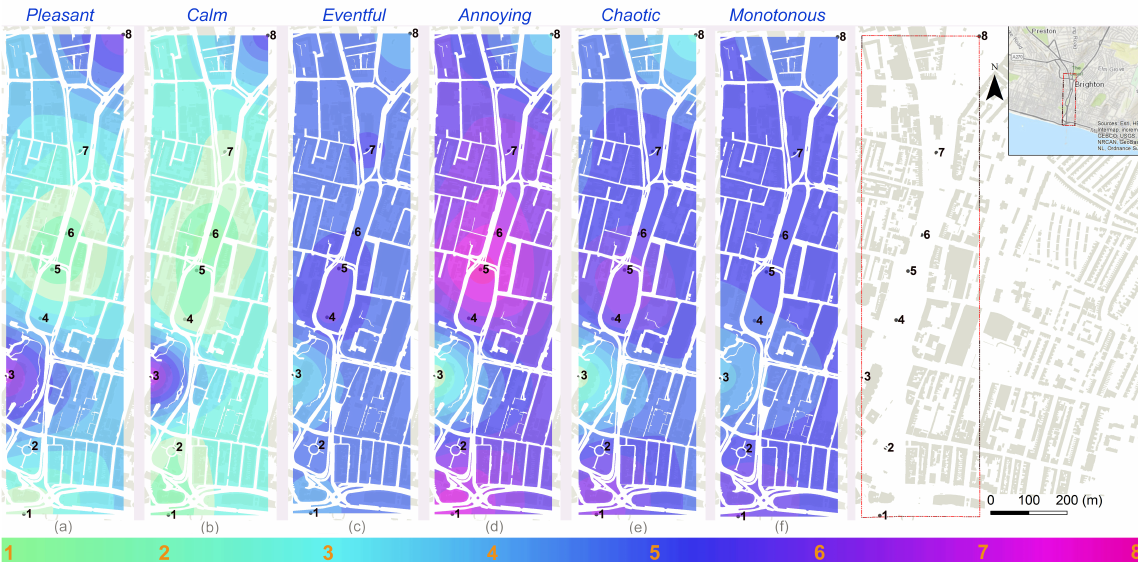
Figure 6: Measurment points and soundscape maps within the study area in Brighton according to the selected perceptual attributes: a) Pleasant, b) Calm c) Eventful, d) Annoying, e) Chaotic, f) Monotonous. The colour ramp ranges between 1 and